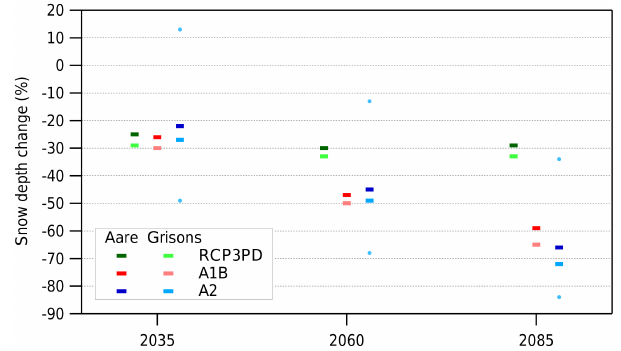
Figure 3. Decrease in annual mean snow depth (%) relative to the reference period (1999–2012) for the Aare region and the Grisons region for the three different emission scenarios and time periods based on the median estimate change of temperature and precipi- tation (bars). The lowest and highest estimates (Table 3) are only shown for the Aare regions and A2 scenario